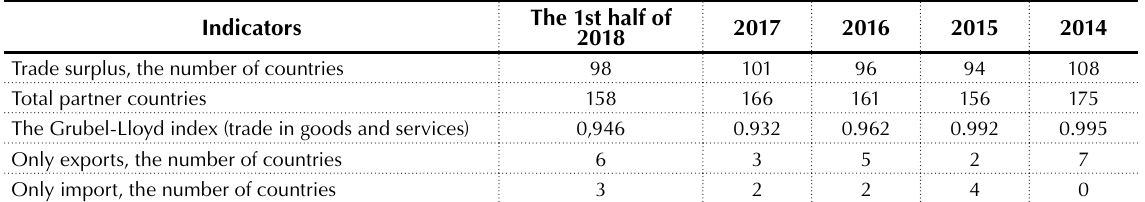
Source: Calculated by the authors on the basis of international trade data of Ukraine.